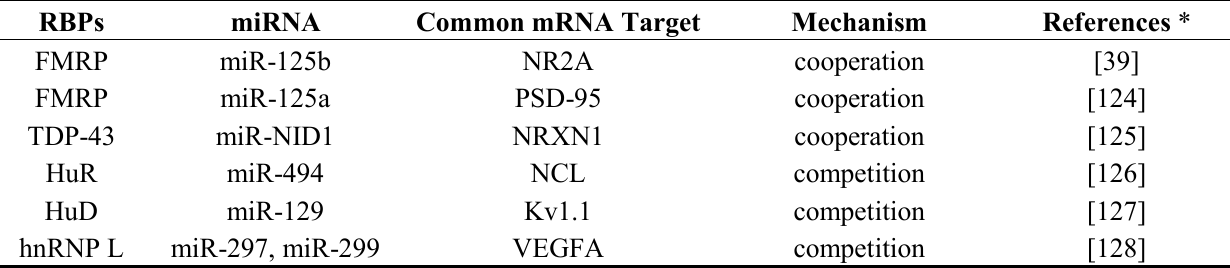
Table 2. RBPs regulating miRNA